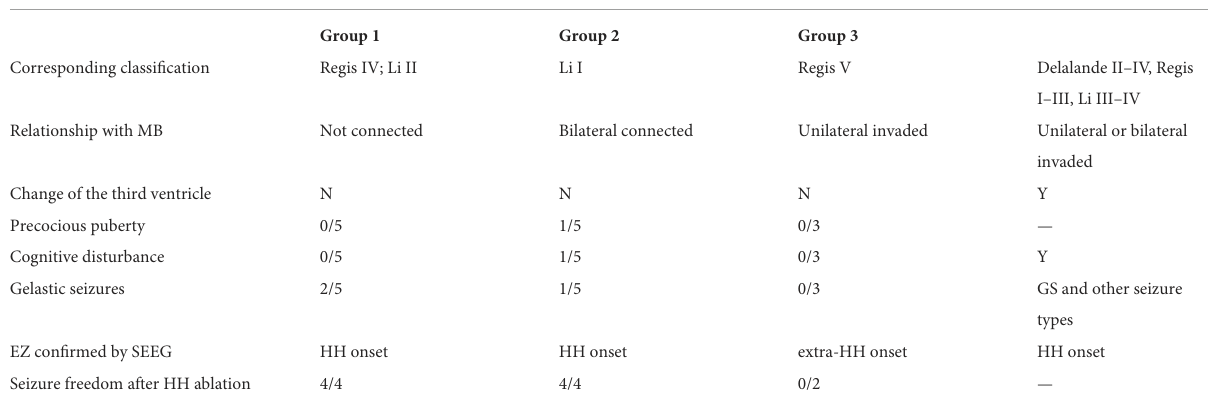
TABLE 2 Comparison of parahypothalamic HH and intrahypothalamic